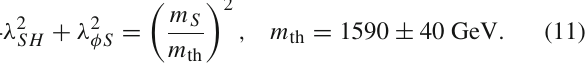
Fig. 2 ThesolidcurvescorrespondtoEq.(11)for (cid:3) φ (cid:4) = 2 . 5TeV(red), 3 TeV (magenta), 4 TeV (green), and 10 TeV (blue), with each width corresponding to the error of m th = 1590 ± 40 GeV. Shaded regions are respectively excluded by the XENON1T experiment (purple), the LHCdata(orange), DMabundance(cyan),andtheperturbativitybound (yellow). Regarding the perturbativity bound, the absence of Landau pole up to μ = 10 17 GeV is